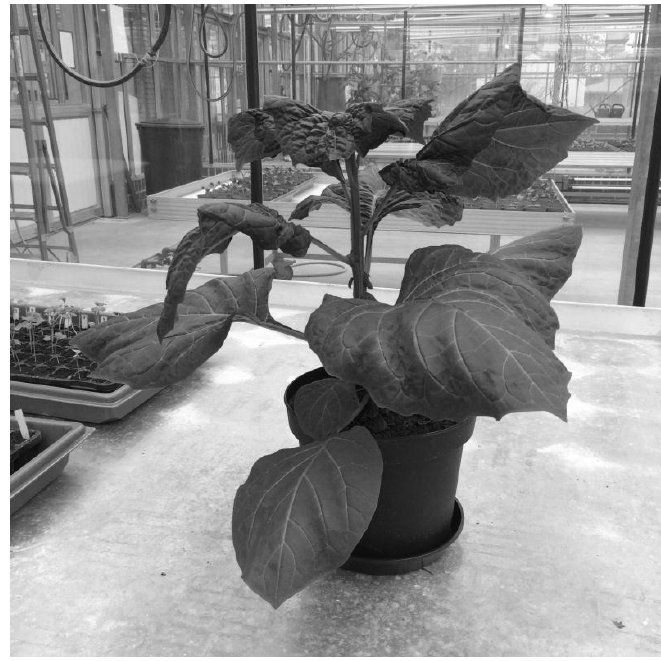
Figure 1. S. scabrum aerial parts.